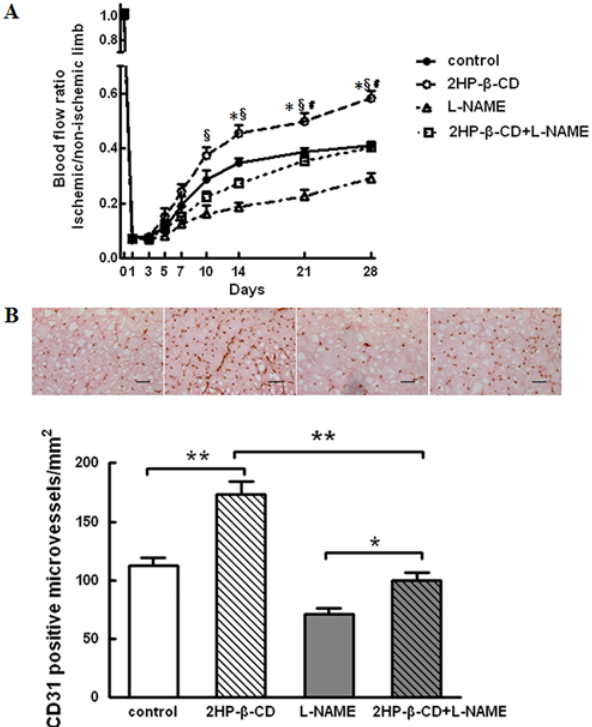
Fig 7. Effect of L-NAME on 2HP- β -CD induced stimulation of blood flow recovery in C57BL/6 mice. A, Ischemic/non-ischemic limb blood flow ratio assessed by LDBF imager in mice in 4 experimental groups; PBS-treated mice with or without L-NAME, 2HP- β -CD-treated mice with or without L-NAME. Data represent the mean ± S.E.M. (n = 10 mice per group). * p < 0.05, 2HP- β -CD-treated mice versus PBS-treated mice. § p < 0.05, 2HP- β -CD-treated mice versus 2HP- β -CD with L-NAME-treated mice; # p < 0.05, PBS with L-NAME-treated mice versus 2HP- β -CD with L-NAME-treated mice. B, Immunohistochemical analysis of CD31 in ischemic hindlimbs of PBS-treated and 2HP- β -CD-treated mice with or without L-NAME. Representative images (upper panel) from calf muscle on postoperative day 28 are shown. Quantitative analysis of CD31-positive microvessel density is also shown (lower panel). Data represent the mean ± S.E.M. (n = 5 mice per group). * p < 0.05. Scale bar = 100 μ